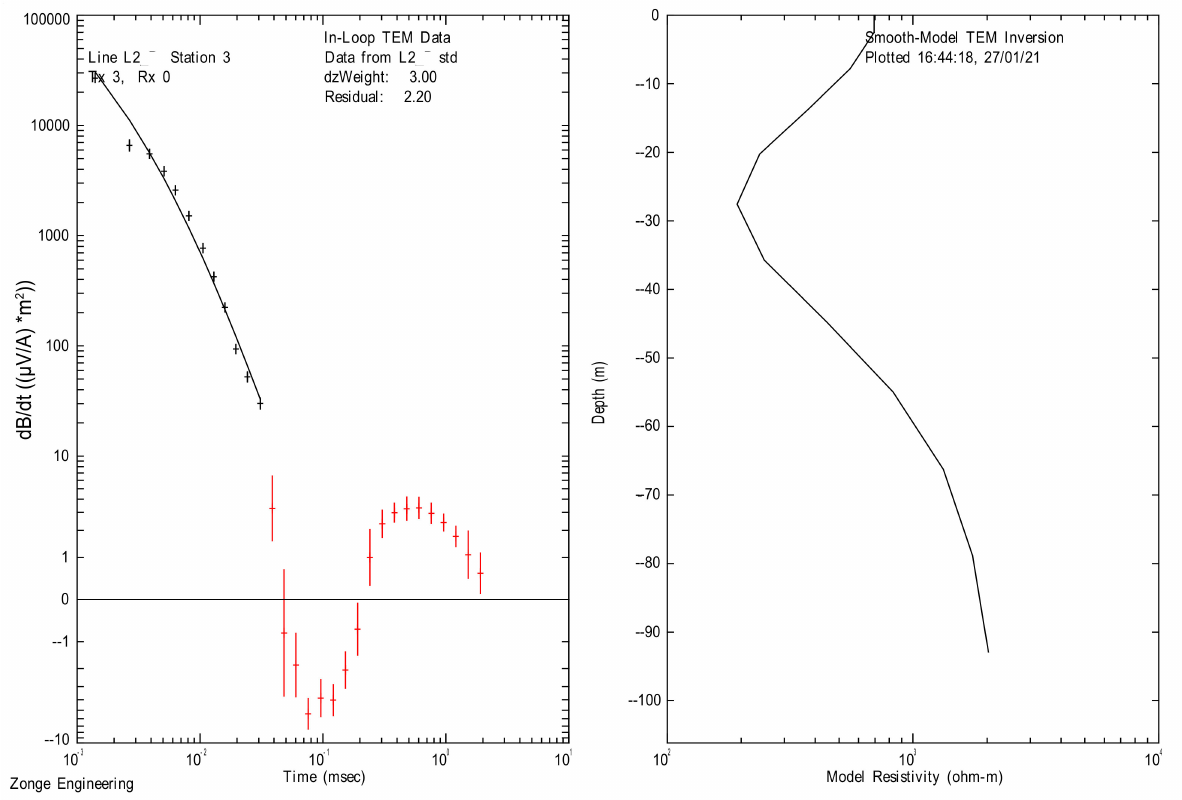
Figure 3. ( Left ) Typical induced voltage decay from Line 2 (L2), Station 3. Measured data are shown as crosses and inversion fitting as a black line. The noise level is approximately 25 µ V/A. The inversion residual is 2.2. ( Right ) The obtained smooth-model TEM